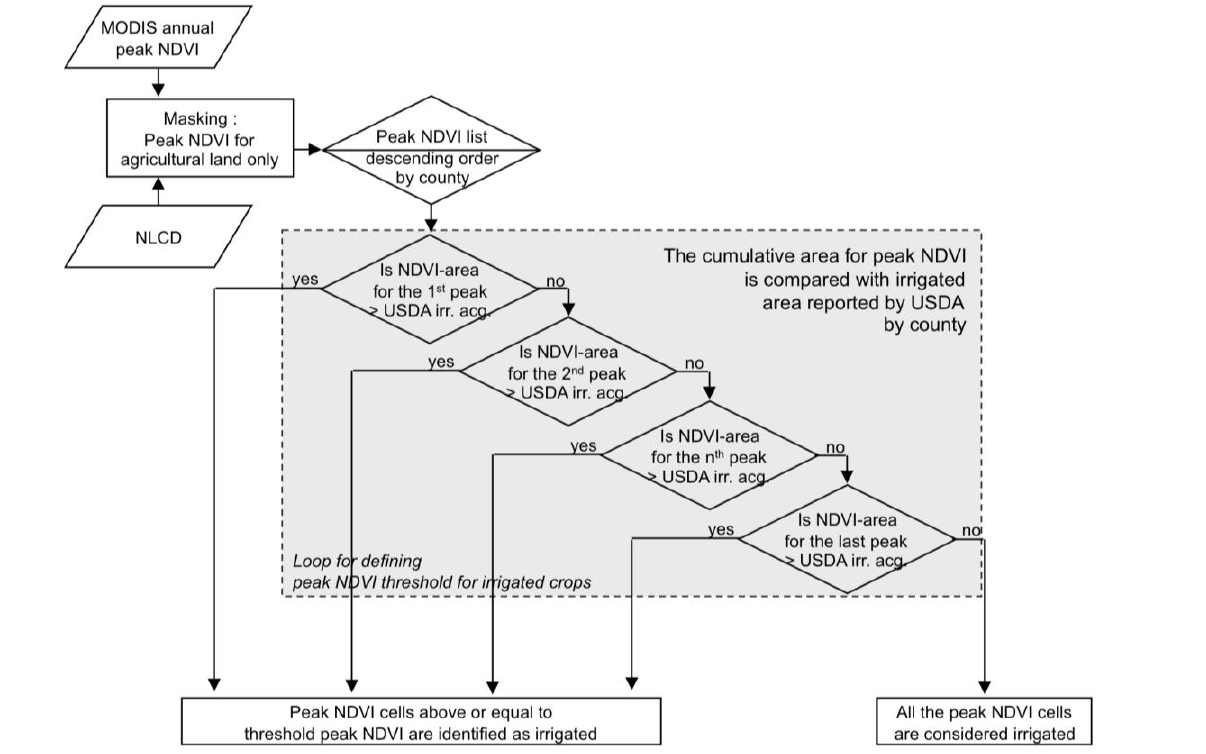
Figure 4. Processes illustration of the Moderate Resolution Imaging Spectroradiometer (MODIS) Irrigated Agriculture Dataset (MIrAD-US) geospatial model; the USDA irr. acg. refers to the county irrigation acreage tabular data at 2002 USDA Census of Agriculture; value of n determines number of